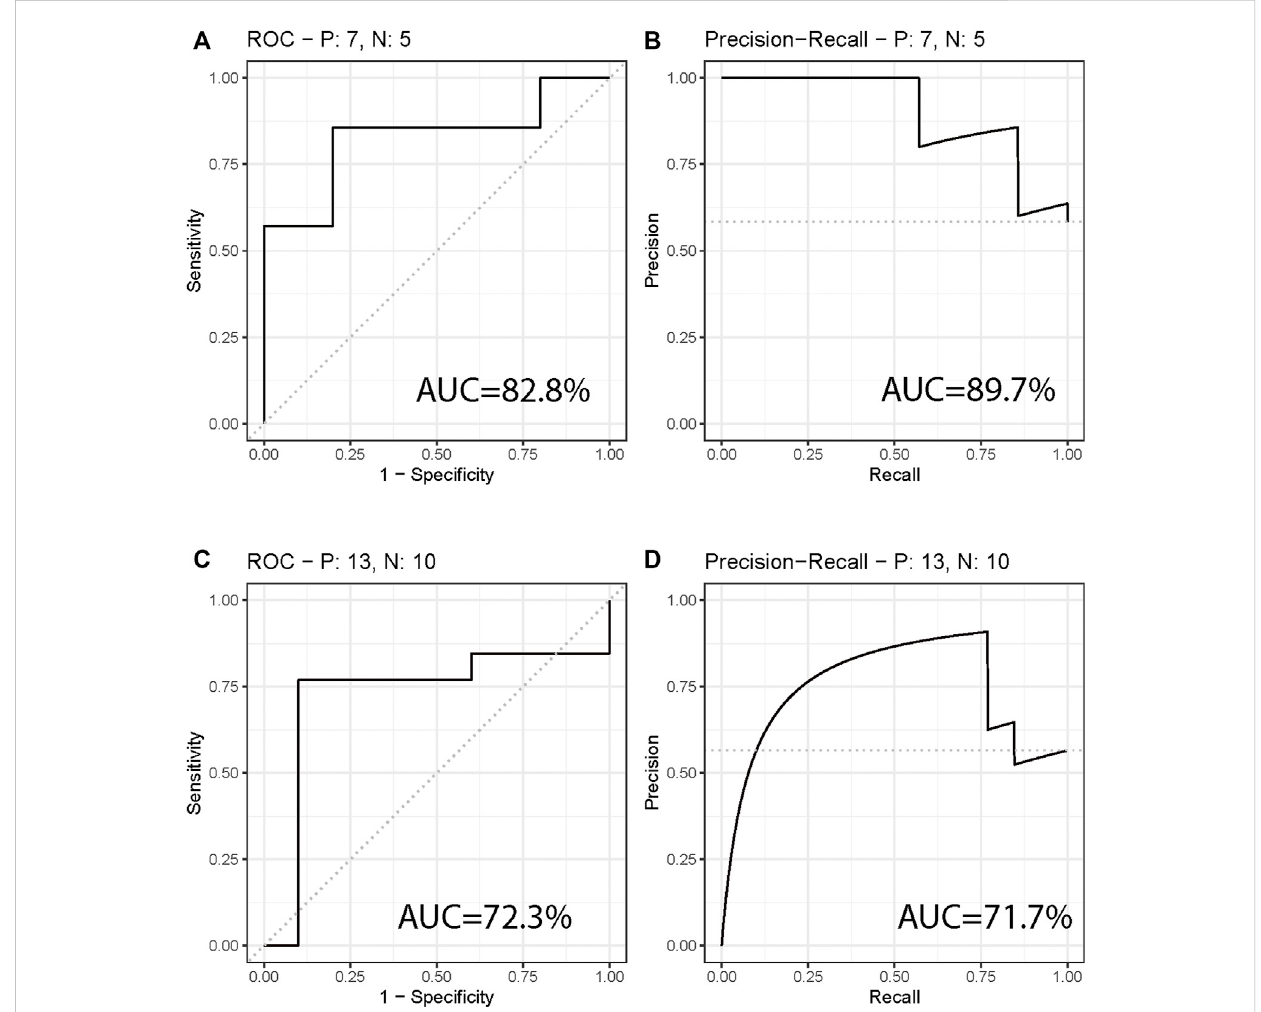
FIGURE 2 Diagnostic Model for Differentiating Nasal Pharyngeal Cancer from Normal. (A,B) ROC curve and PR curve showing the performance of the diagnosticmodelindifferentiatingNasalPharyngeal CancerandNormalgroups.TheareasundertheROCcurve(AUC)are82.9%and89.7%respectively. (C,D) ROC curve and PR curve showing the performance of the diagnostic model in an independent validation set. The AUC areas are 72.3% and 71.7%